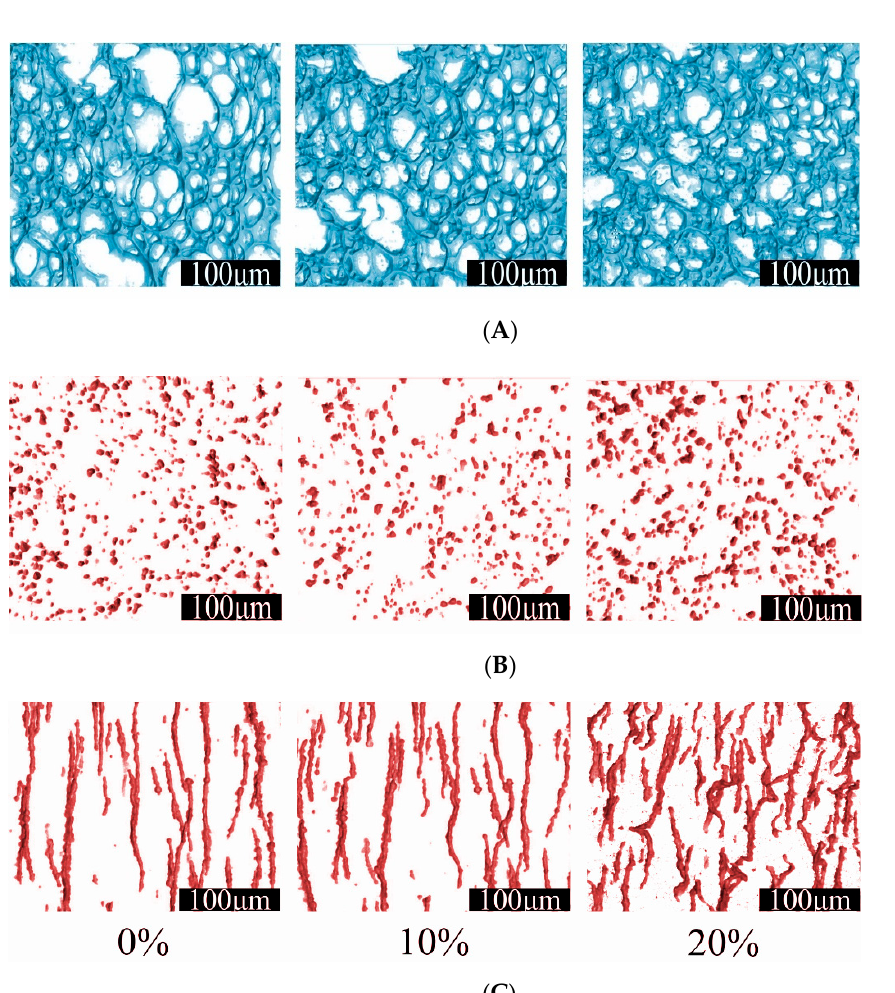
Figure 8. Microtomographic reconstructions at different strain levels of three representative samples: ( A ) PU, ( B ) RF, ( C ) AF_189_T0-10.